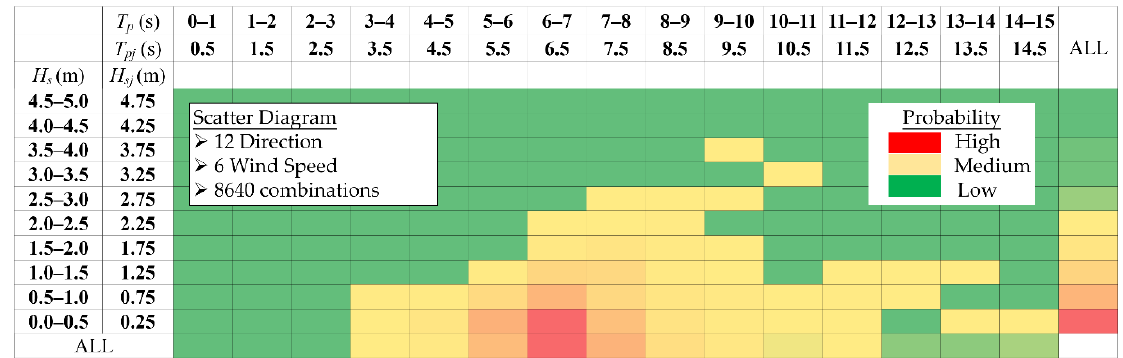
Figure 2. Scatter diagrams of wave height ( H s ) and peak period ( Tp ) on the basis of a preliminary site survey that was conducted from December 1991 to August 1999 at the THL3 weather station,